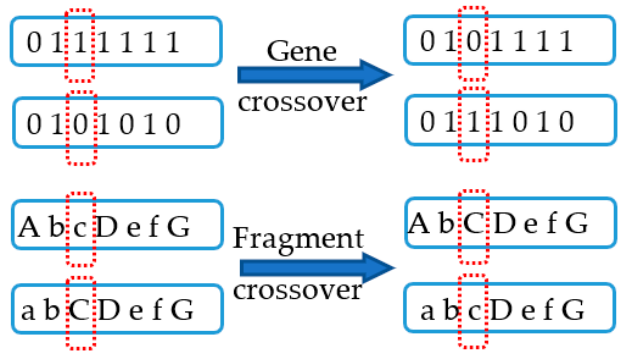
Figure 8. Diagram of crossing.